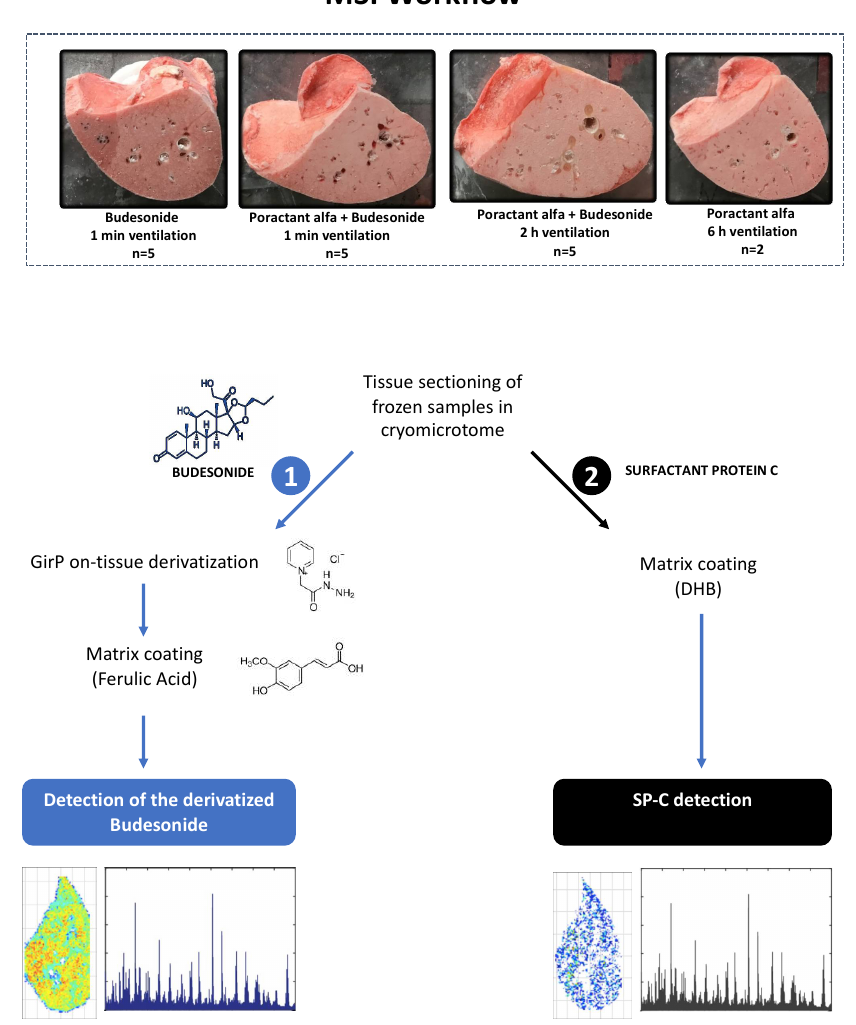
Figure 1. Mass spectrometry imaging (MSI) workflow applied in the present study. The lower lobes of right lungs from premature lambs receiving either budesonide alone or in combination with surfactant were analyzed. Two additional animals that did not receive budesonide were also included in the study as negative controls. Two consecutive transverse tissue sections of 20 µm thickness were obtained from each sample. (1) One of the sections was used for budesonide analysis, which required on-tissue derivatization with Girard reagent P (GirP) followed by matrix coating with ferulic acid. (2) The second tissue section was used to analyze the spatial distribution of surfactant protein C (SP-C). A MALDI-LTQ-Orbitrap XL mass spectrometer was used for budesonide analysis,